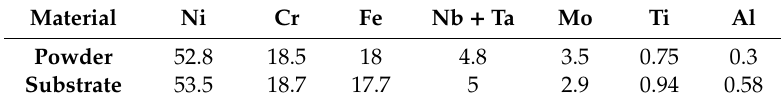
Table 1. Chemical composition of Alloy 718 powder and substrate (wt. %).